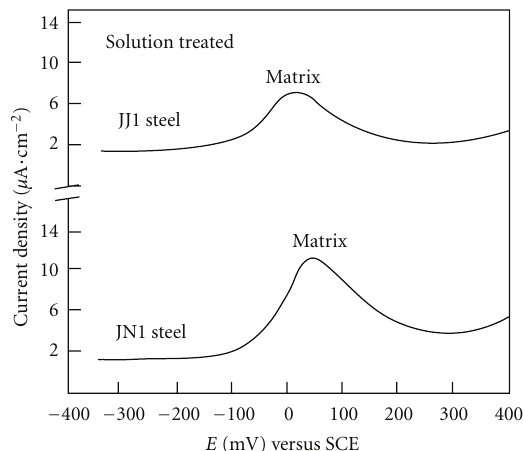
Figure 3: Anodic polarization curves of JJ1 steel and JN1 steel solution treated.